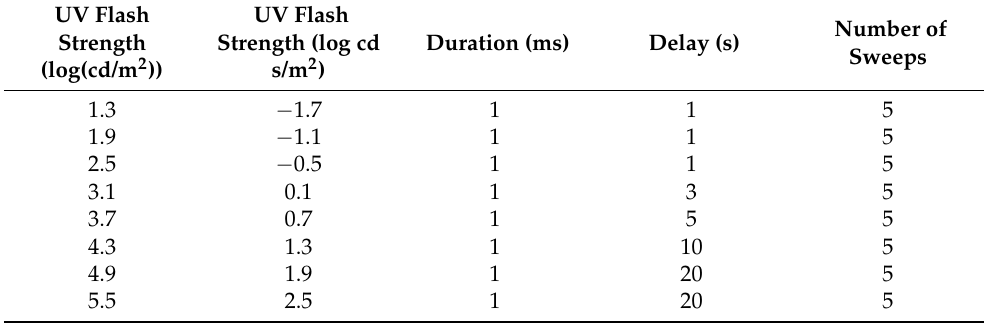
Table 1. Full scope of electroretinogram (ERG) intensity flashes and stimulus